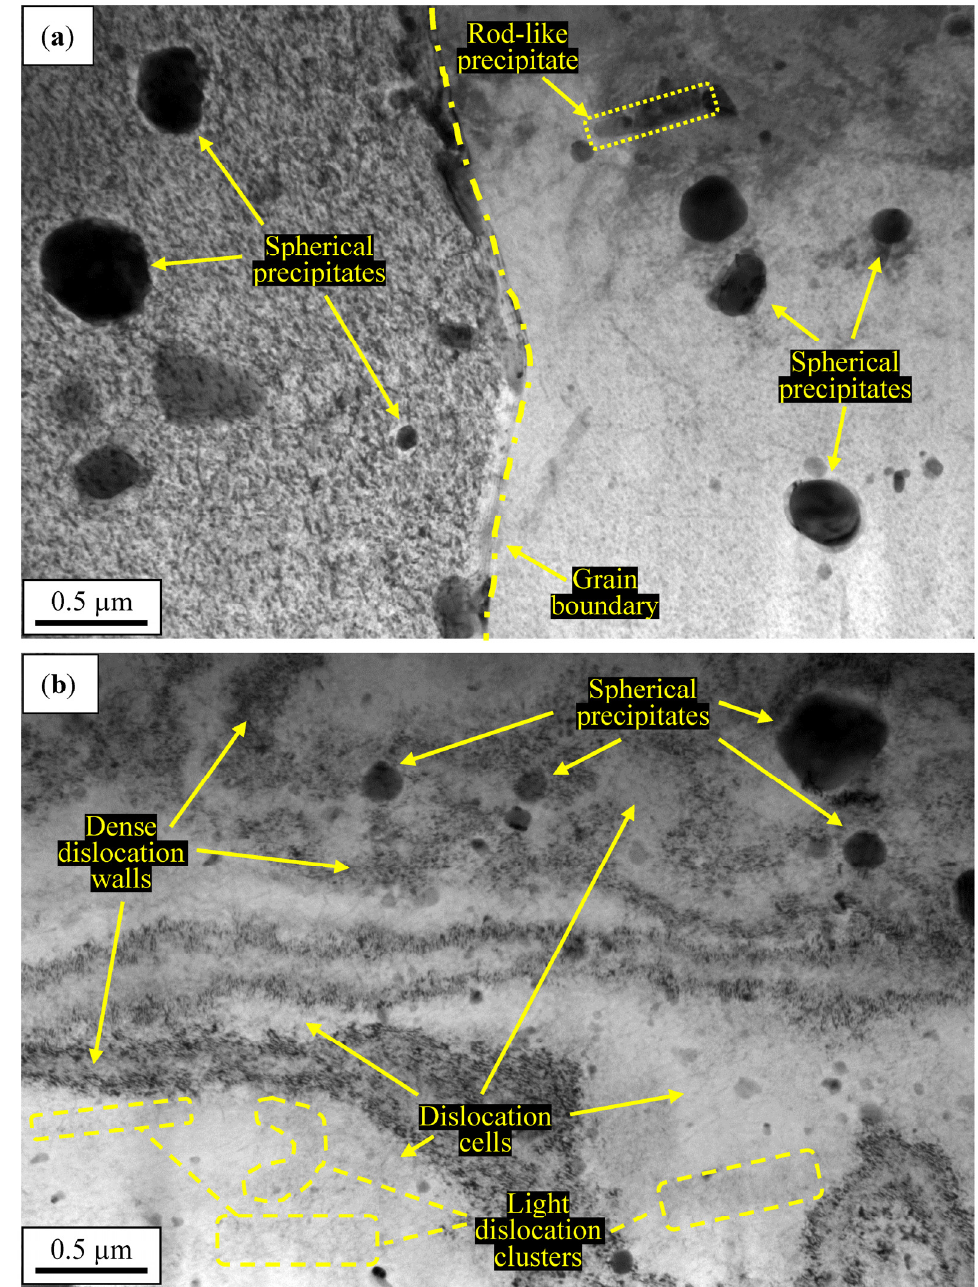
Figure 7. TEM images of the base material ( a ) and sample C1.6 ( b